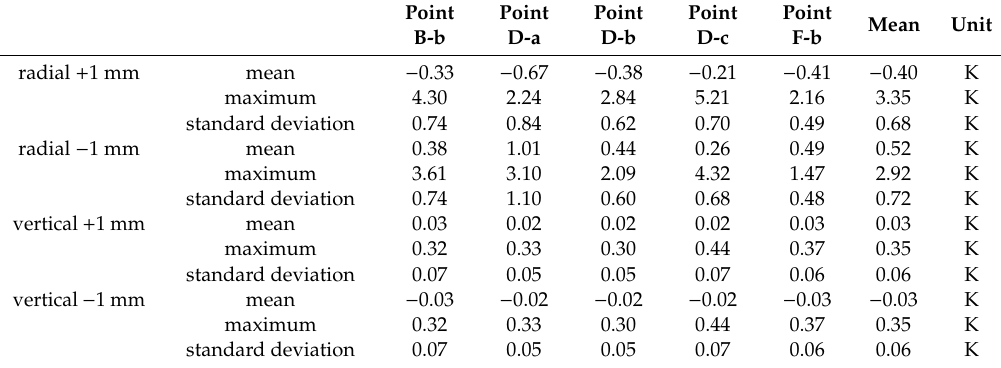
Table A2. Temporal mean, maximum, and standard deviation of the temperature measurements with a varied measurement point position with respect to the reference